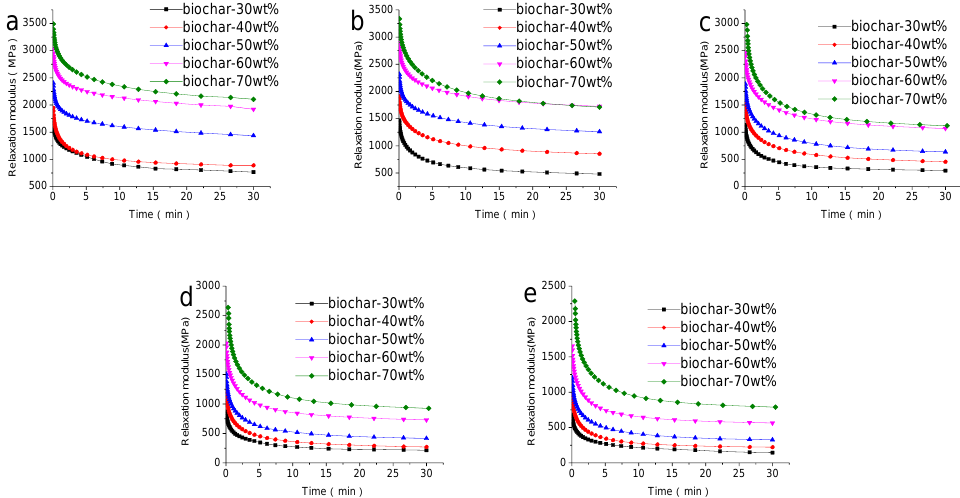
Figure 5. The stress relaxation modulus curves of WPC with different biochar-plastic ratio under different temperatures: ( a ) 25 °C; ( b ) 35 °C; ( c ) 45 °C; ( d ) 55 °C and ( e ) 65 °C.